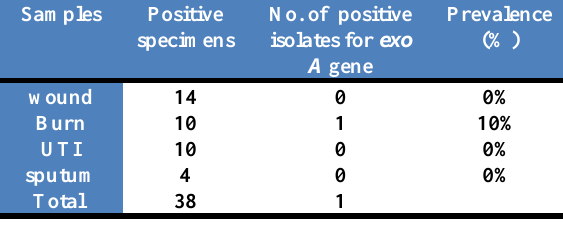
Table, 8: PCR results for exo A gene amplification in different clinical samples.